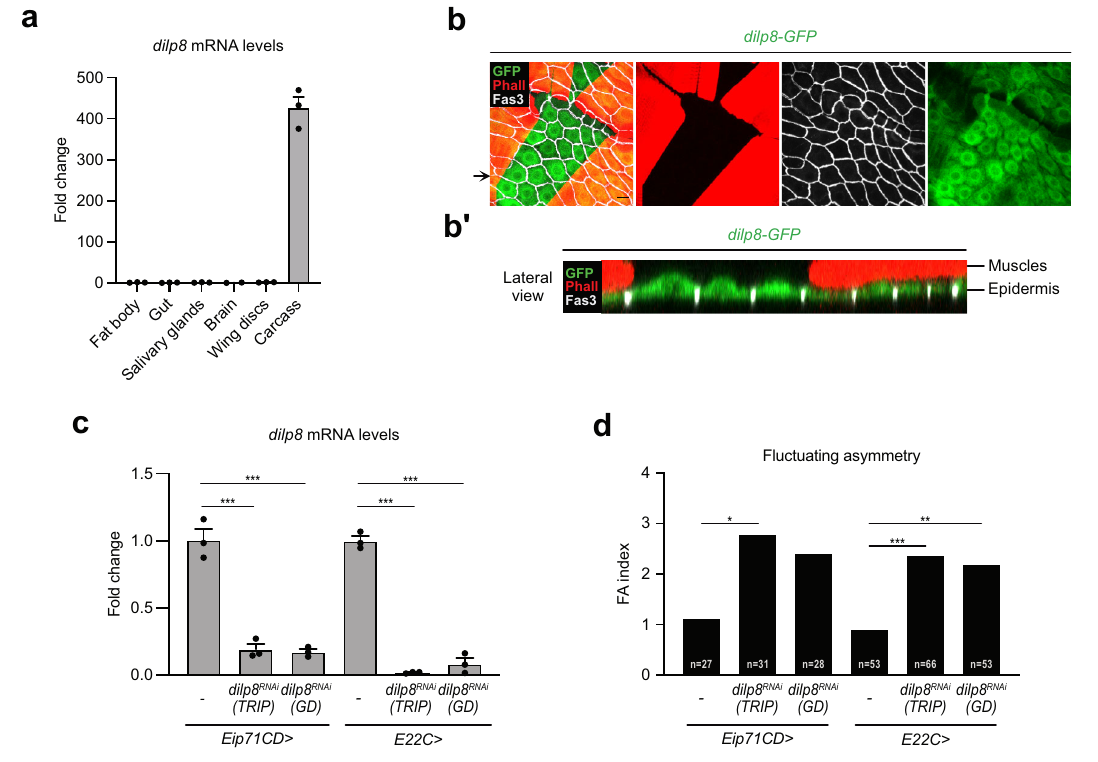
Fig.3|TheepidermisisthesourceofDilp8attheWPPstage.a Measurementof dilp8 mRNAlevelsbyqRT-PCRondissectedtissues( w 1118 controlstrain)attheWPP stage. Values are expressed as fold changes relative to the fat body. Error bars representSEM. n =3biologicallyindependentsampleswereanalyzedforalltissues, except for the brain where n =2. b Maximal projection of a fi llet preparation showingexpressionofthe dilp8-GFP reporterattheWPPstage.Phalloidin(Phall,in red) staining marks actin fi laments in the muscles and Fasciclin 3 (Fas3, in gray) marks the cell membranes of epidermal cells. The arrow on the side indicates the planeforlateralviewreconstruction.Scalebarrepresents20 μ m. b ′ Lateralviewof the preparation presented in b , showing that dilp8-GFP is expressed in the layer corresponding to epidermal cells and not in the muscles. This experiment was